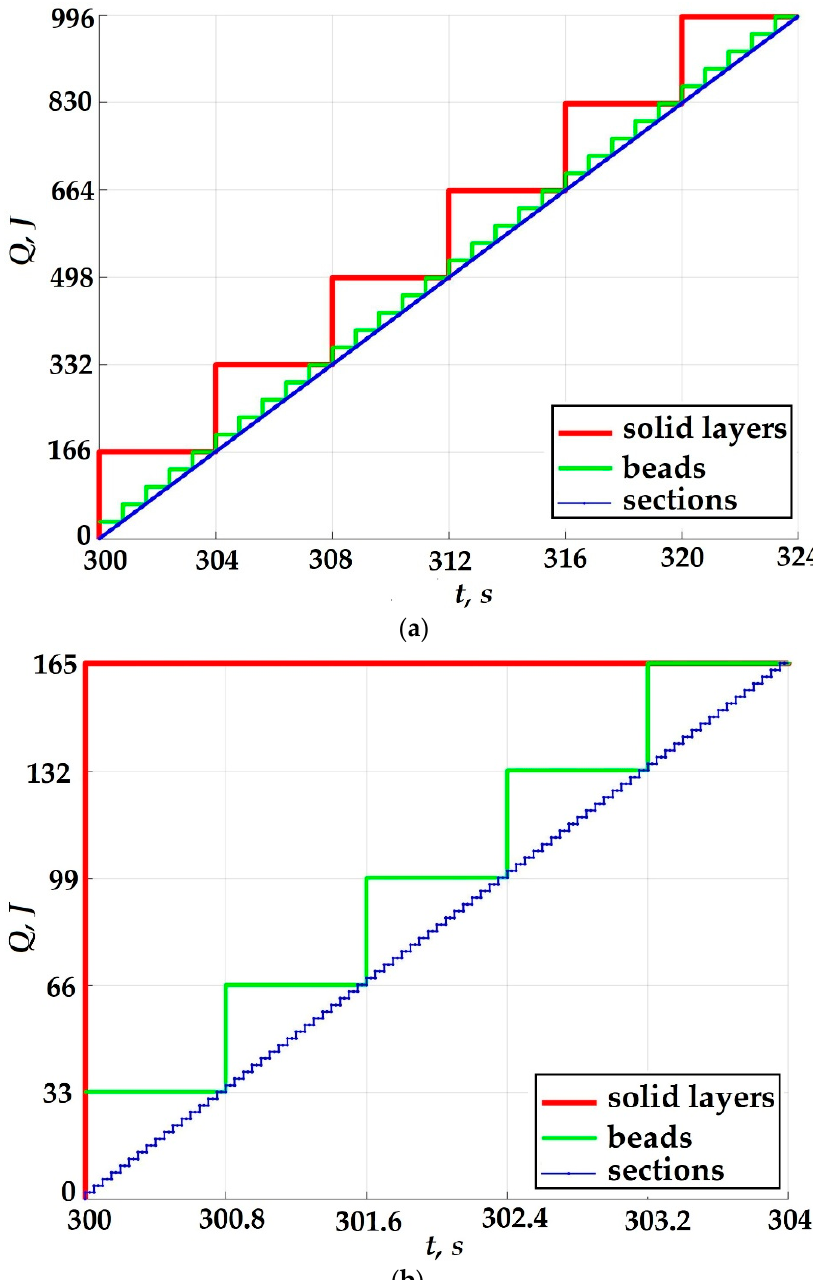
Figure 18. Increasing the degree of detail of the heat source trajectory: ( a ) solid (1 step—1 layer); ( b ) beads (1 step—1/5 of the layer); ( c ) sections (1 step—1/40 of the layer).